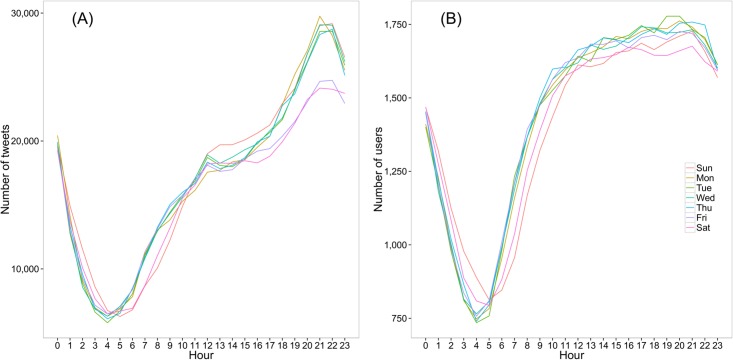
Daily and weekly rhythms of Twitter activity.(A) Tweets posted by hour and day of the week. (B) Number of active users by hour and day of the week. We used the UTC-offset information provided by the REST API to normalize time stamps to local time (see S1 File).